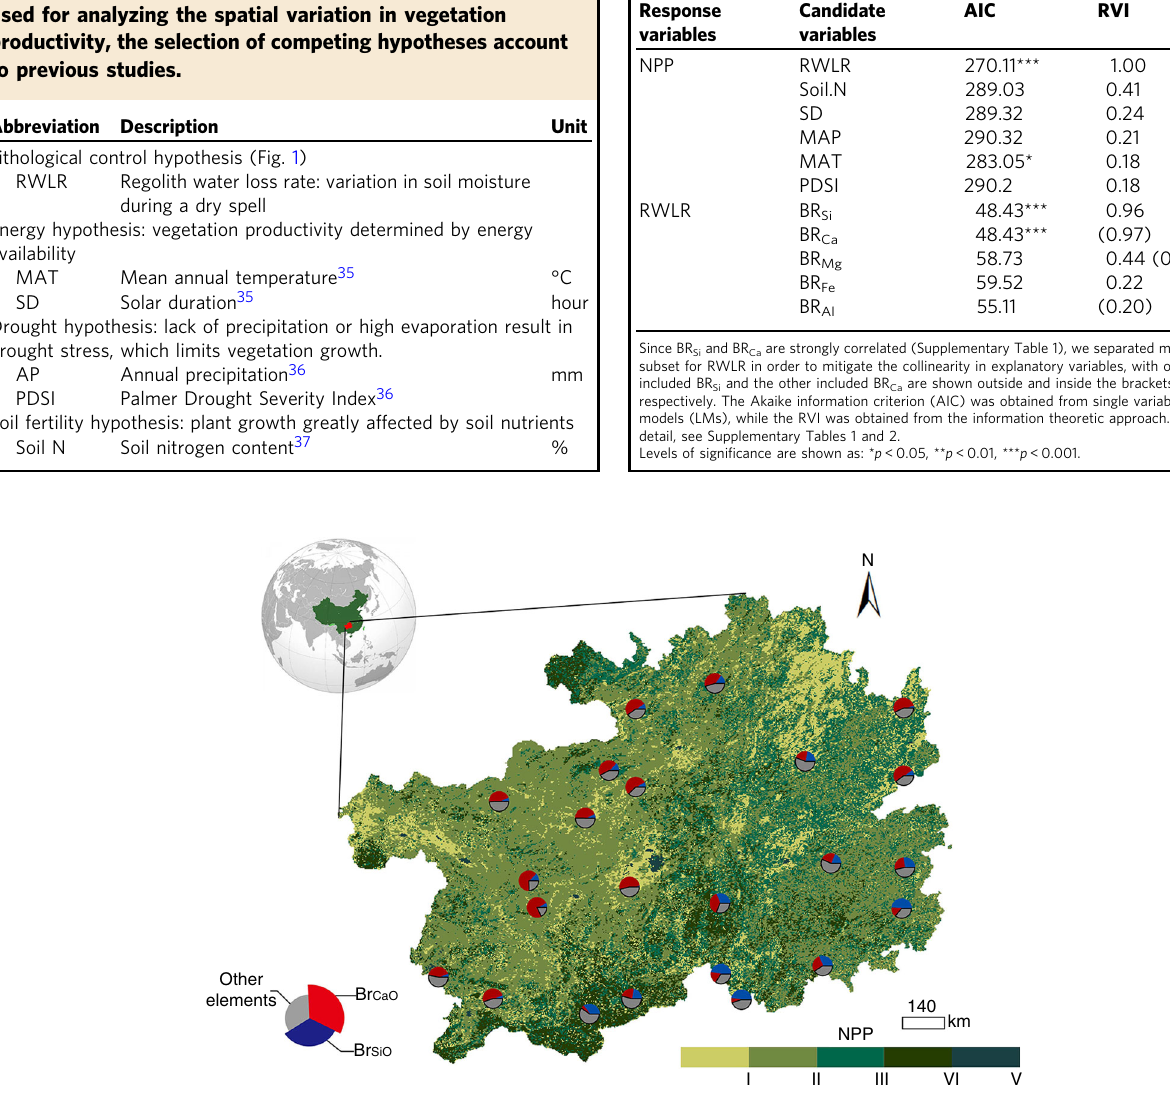
Fig. 2 Spatial distribution of critical zone units in Guizhou. The pie chart represents the location of the critical zone units considered in this study. The different colors within the pie charts represent the bedrock concentrations of the elements. Each critical zone unit has a meteorological observation station at the center with a radius of 20 km. the net primary productivity (NPP, g Cm -2 yr -1 ) is divided into fi ve levels, i.e., I: 0.00 – 319.83, II: 319.83 – 513.40, III: